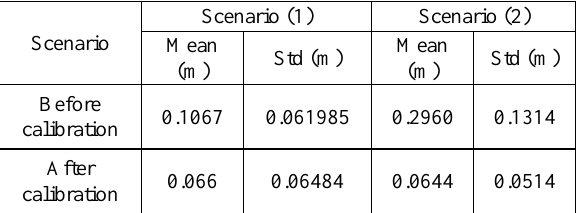
Table 1. The mean and the standard deviation of the distance between the LIDAR and images-driven point clouds before the calibration and after the